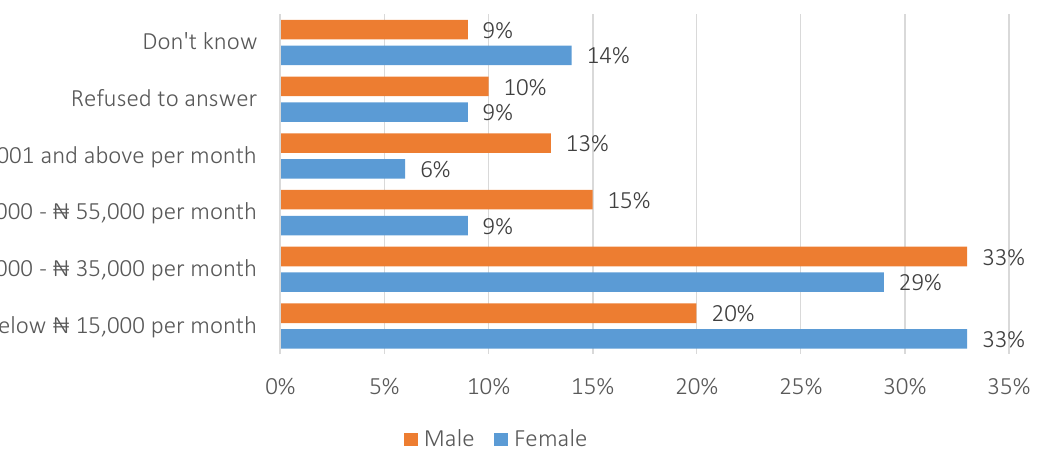
Figure 1. Average monthly income of men and women